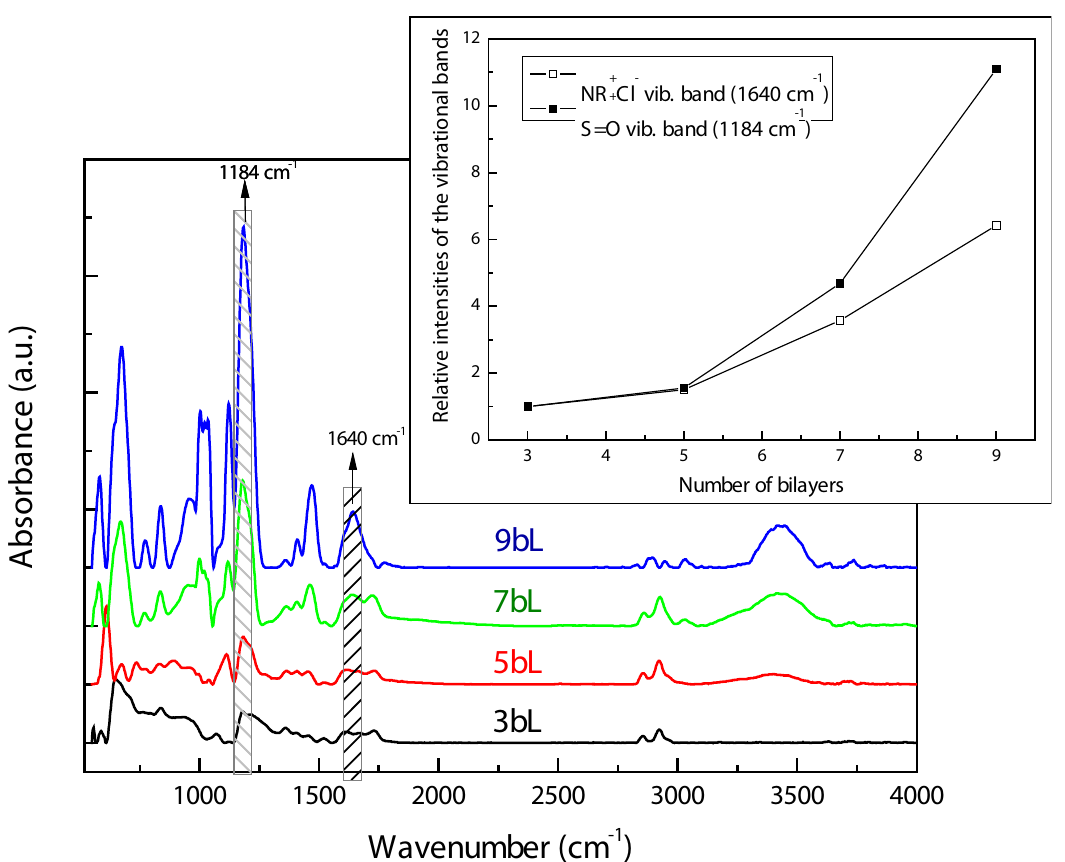
Figure 4. ATR-IR spectra of the modified silicon surface with different numbers of polyelectrolyte bilayers; insert: the relative intensities as number of bilayers of two vibrational bands, which demonstrate the build-up